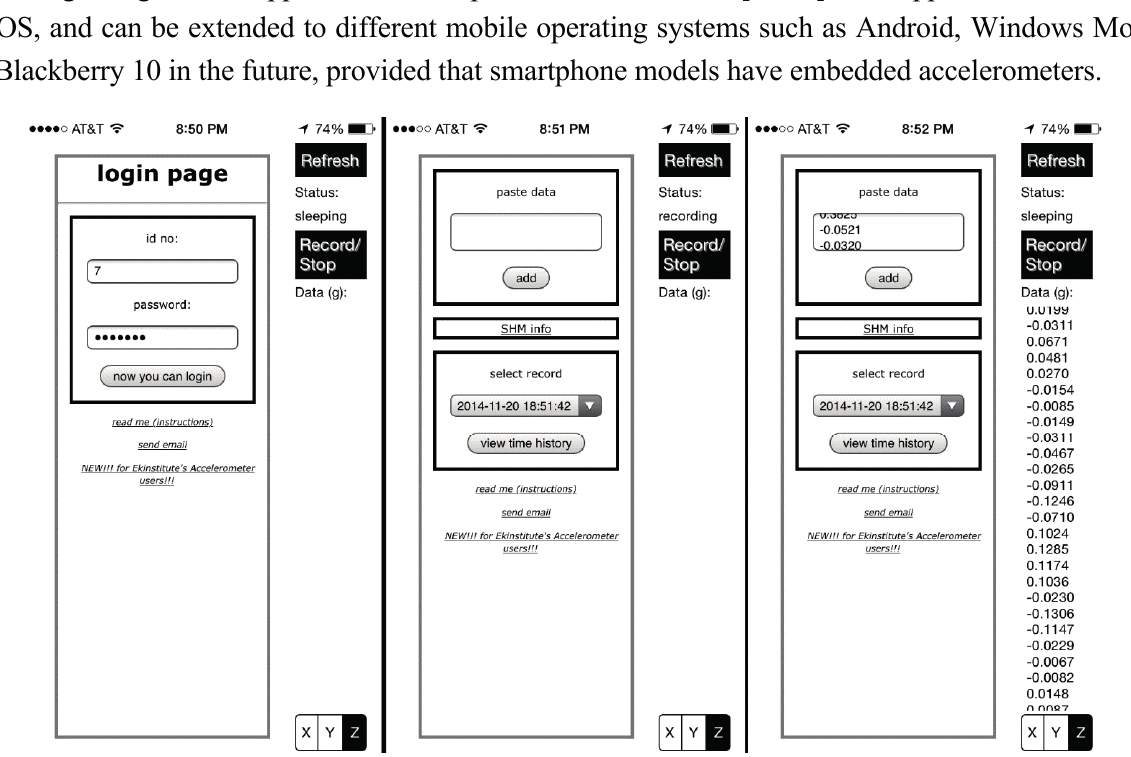
Figure 2. User login, recording, and submission screenshots,